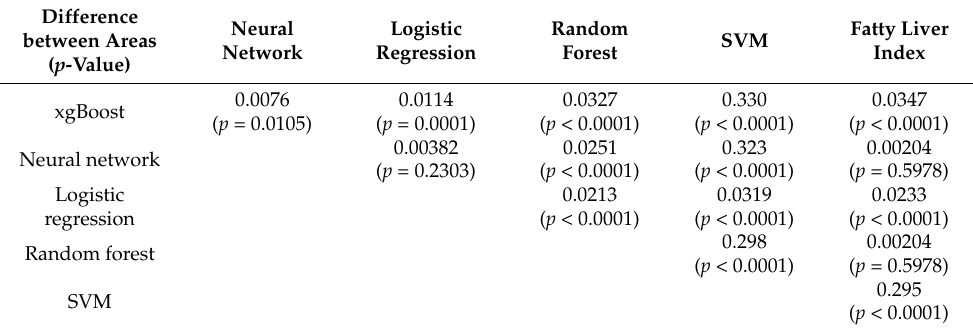
Table 4. Pairwise comparison of the AUROC of different machine-learning models and the fatty liver index on the testing